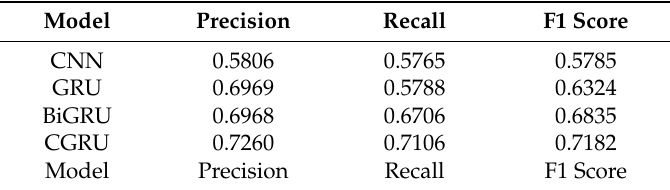
Table 3. Model results for Z_all dataset.